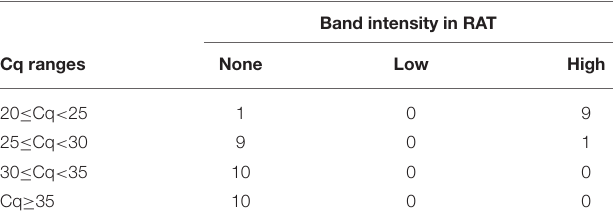
Band intensity in